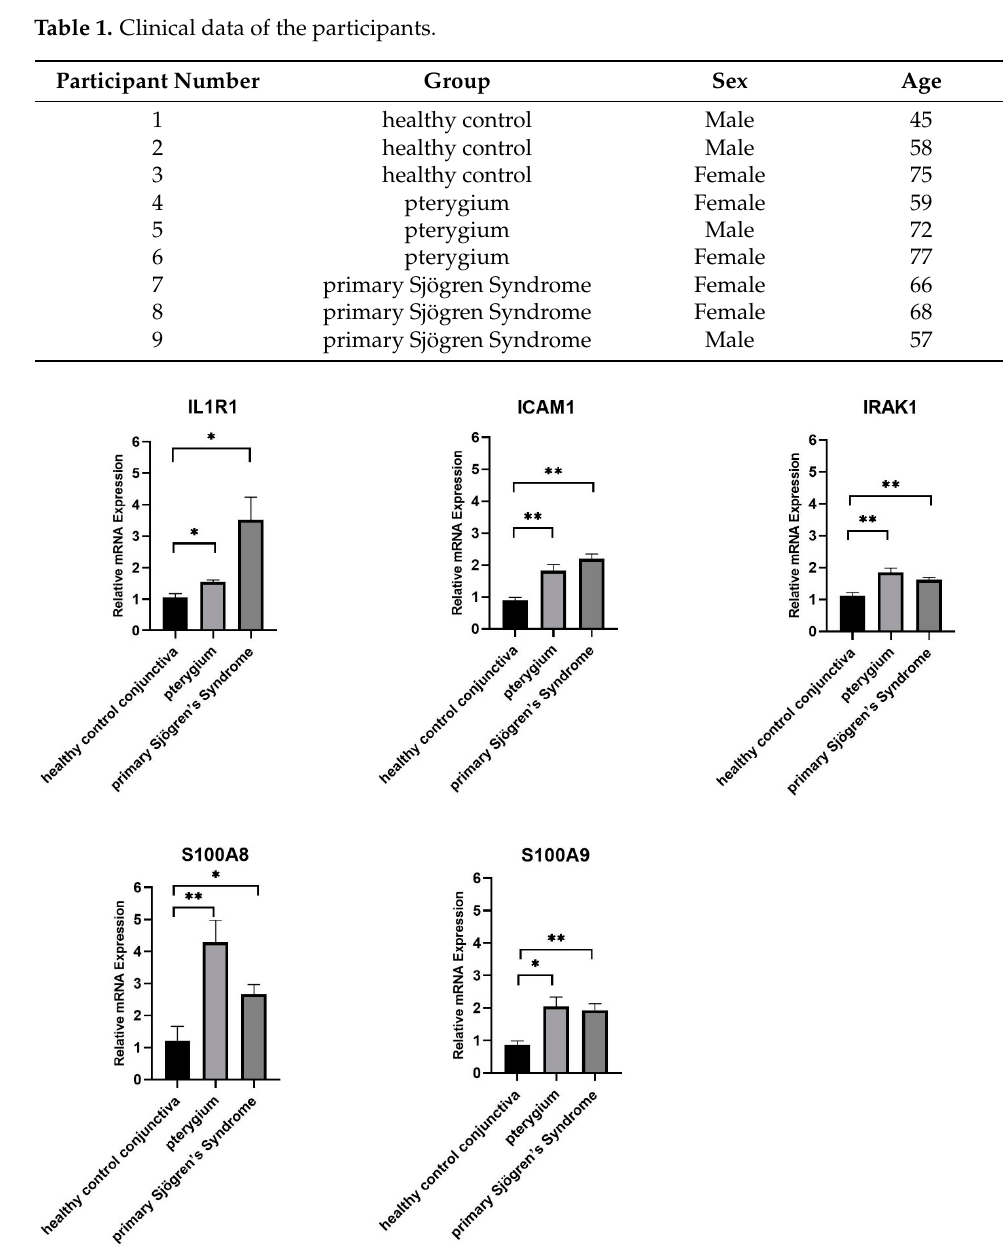
Table 1. Clinical data of the participants.